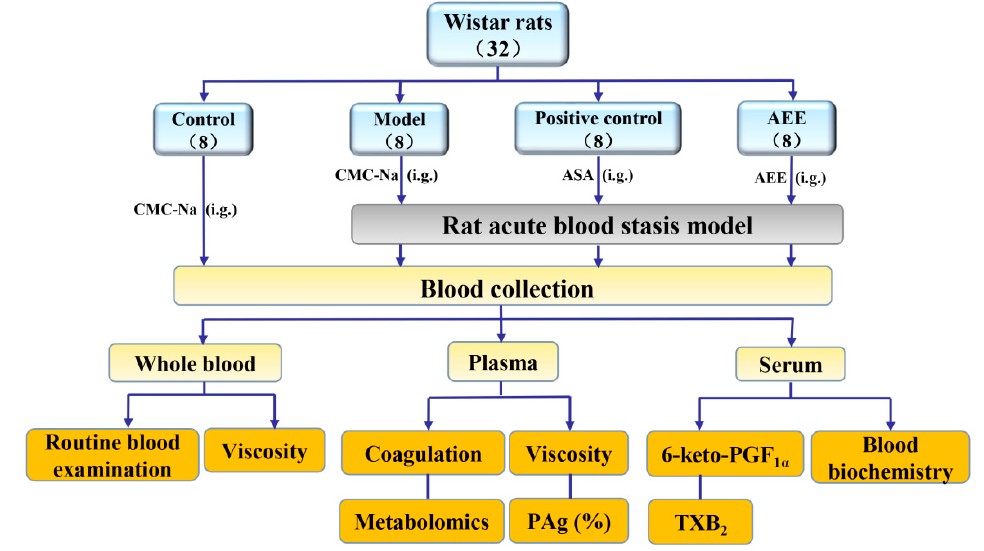
Figure 5. Study design of this experiment. i.g.: intragastric administration; PAg%: platelet aggregation rate.